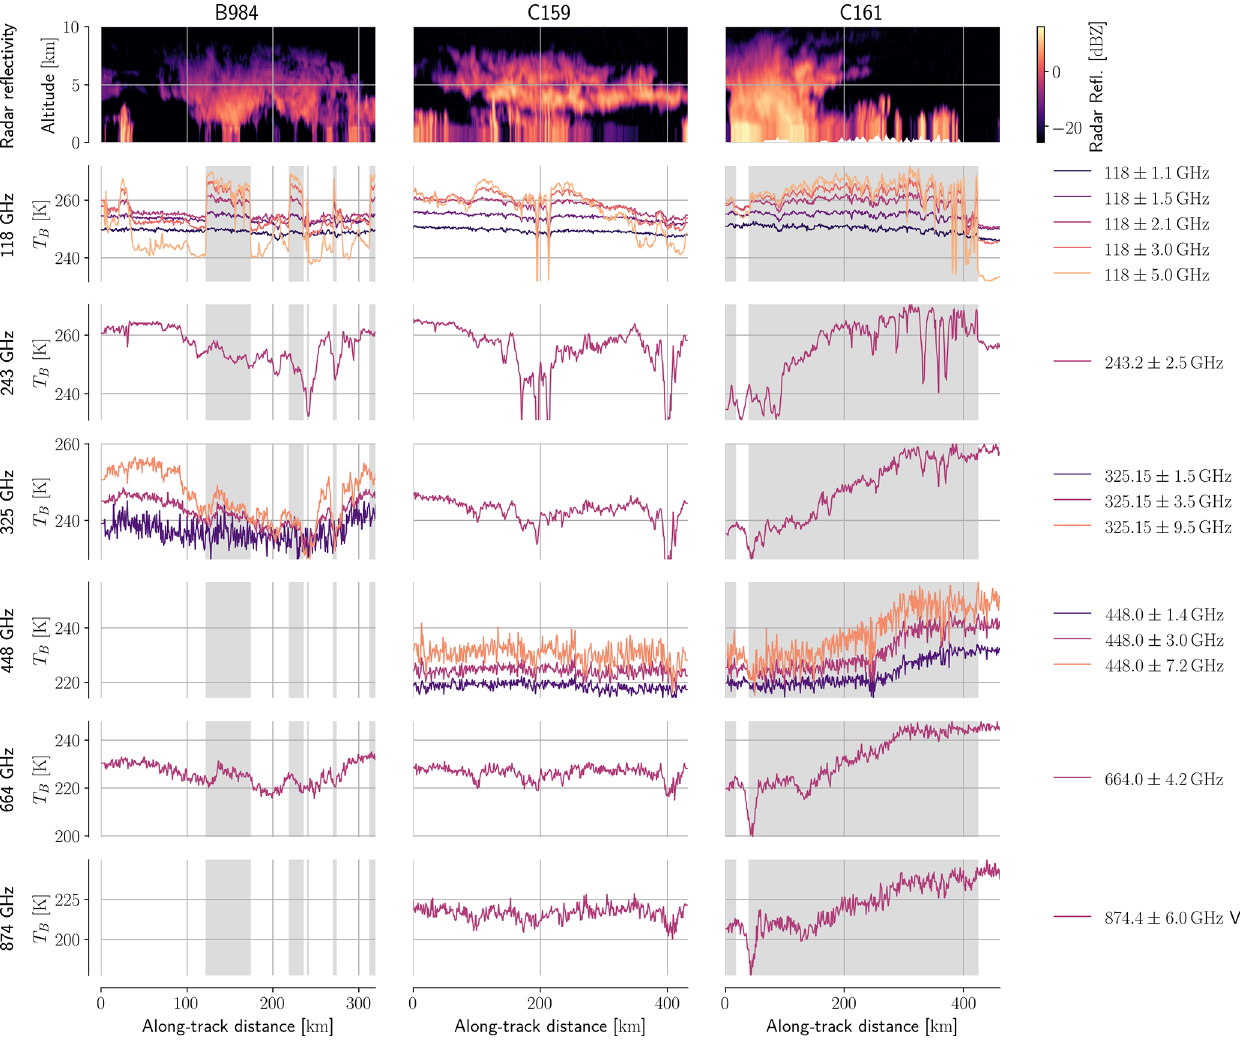
Figure 5. Passive microwave measurements from the ISMAR radiometer together with the matched radar observations. Grey background in the radiance plots marks observations that were taken over land and are therefore not used in the retrieval.